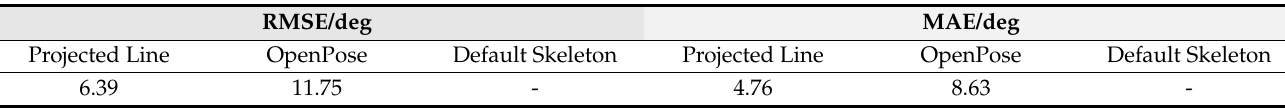
Table 5. In walking test, error values obtained by the projection lines method based on Mask RCNN proposed in this work, OpenPose software and the Kinect default skeleton, versus the IMUs gold